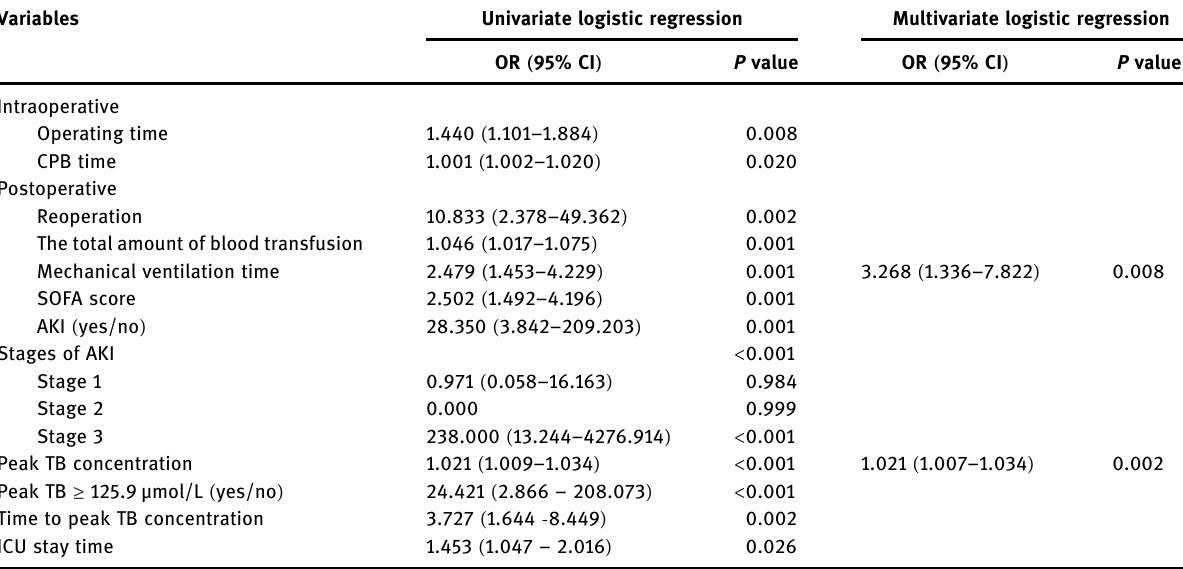
Table 4: Logistic regression analysis for in - hospital mortality